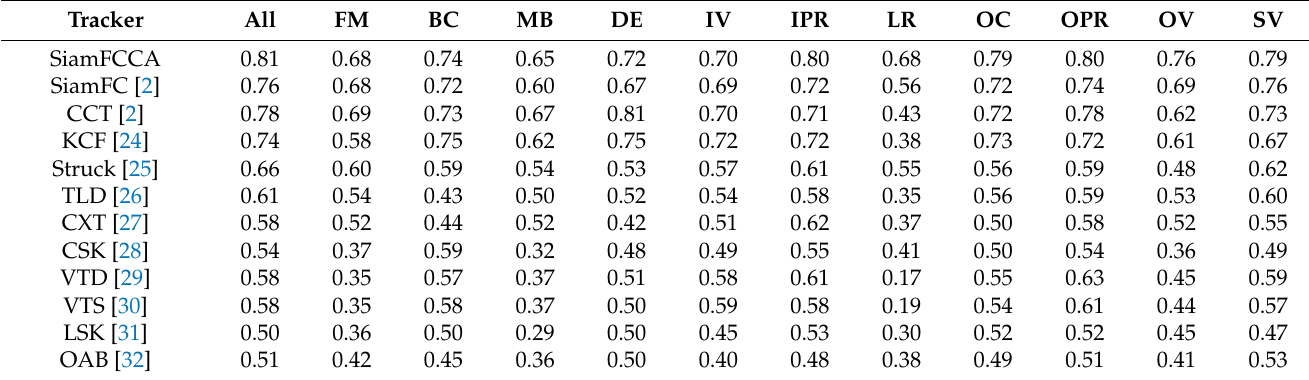
Table 2. The comparison of precision scores of all trackers in all categories.